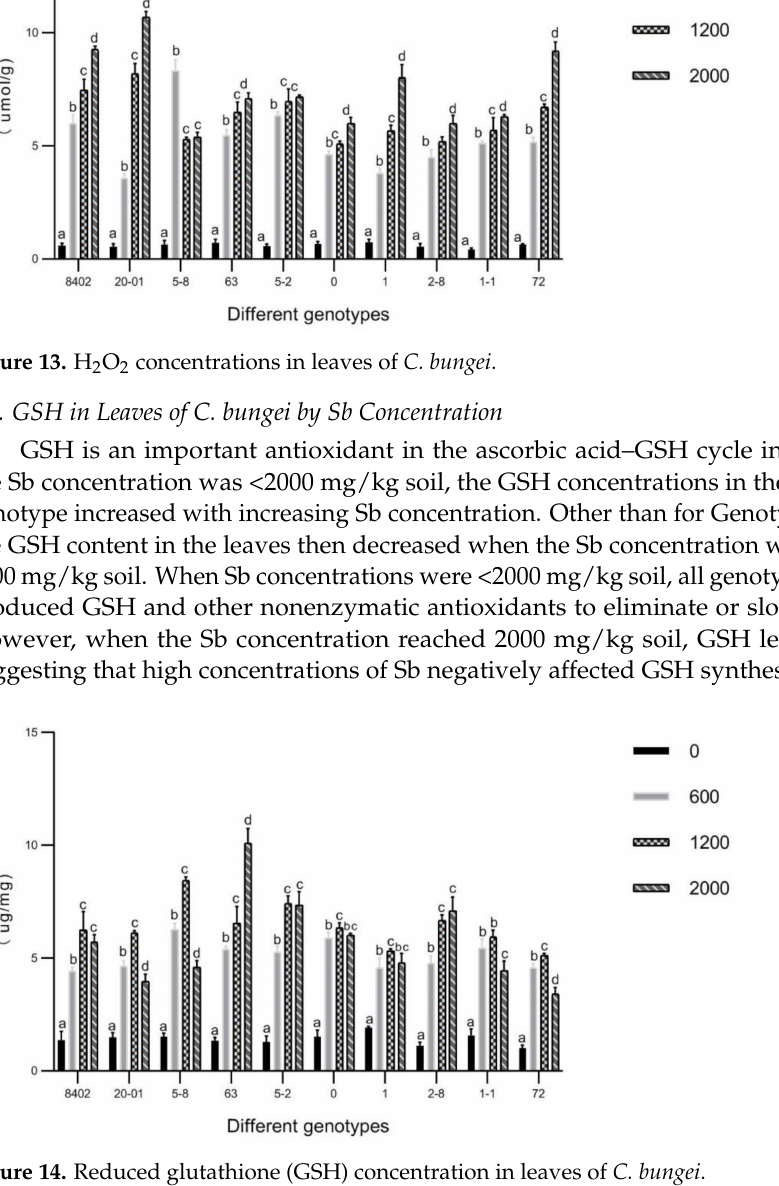
Figure 14. Reduced glutathione (GSH) concentration in leaves of C. bungei